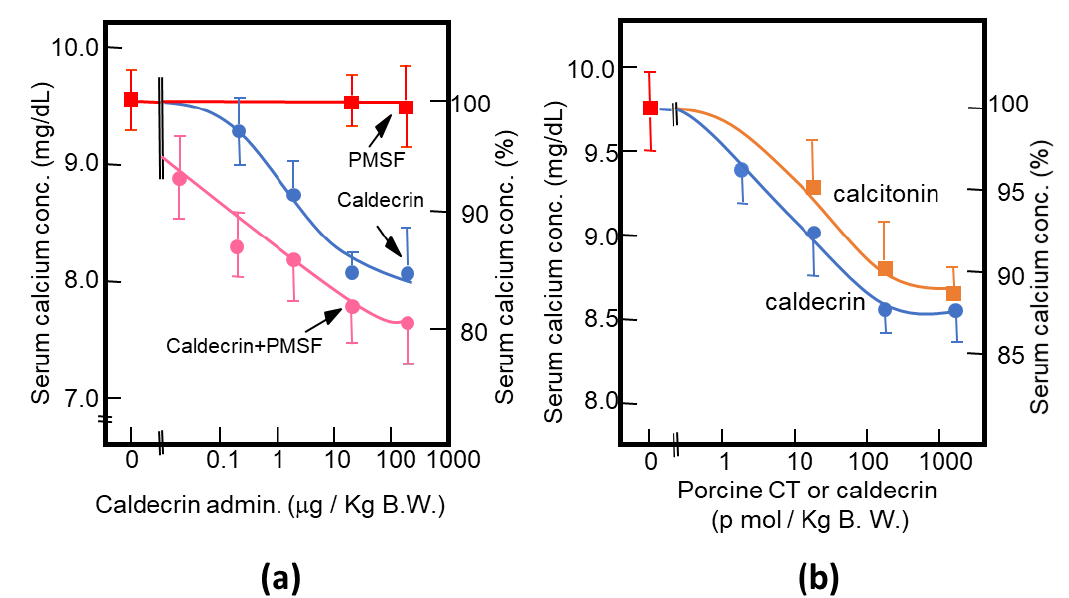
Figure 3. Characterization of the serum calcium-decreasing activity of caldecrin. ( a ) PMSF treatment does not inhibit the serum calcium-decreasing activity of activated caldecrin; ( b ) comparison of the serum calcium decreasing activities of porcine caldecrin and calcitonin.